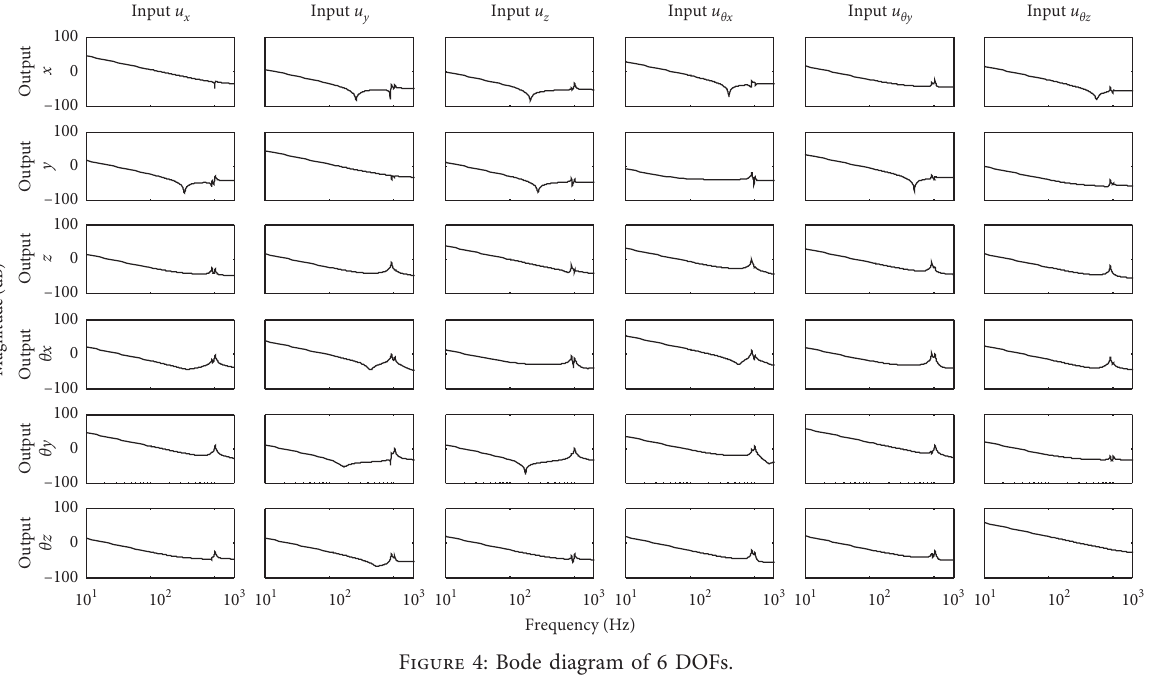
Figure 4: Bode diagram of 6 DOFs.